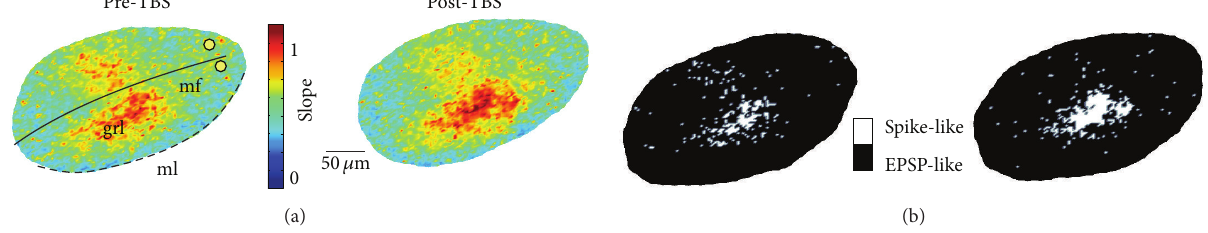
Figure 6: Spatial reconfiguration by LTP and LTD. (a) Vector maps of granular layer before (left) and after TBS (right). (b) The maps are represented by converting spike-like signals into white pixels and EPSP-like signals into black pixels. Plasticity increases the density and amount of spike-like responses in the core of the active area and filters out spike-like responses from the